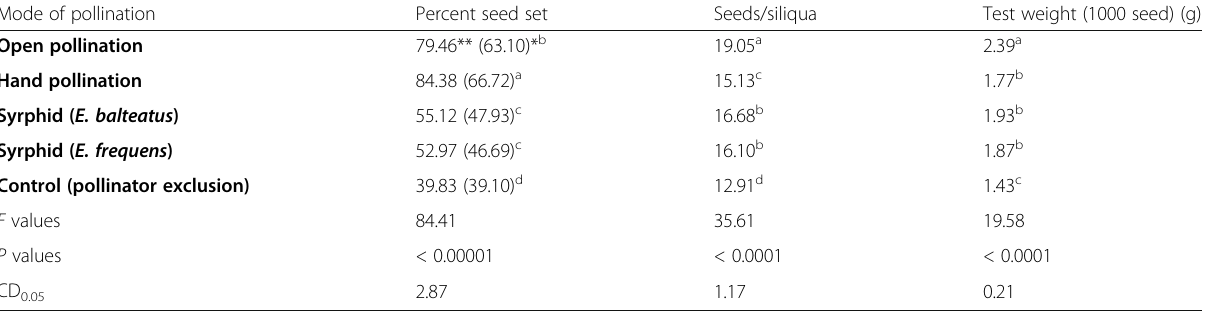
Table 5 Impact of different modes of pollination on percent seed set, number of seeds per siliqua, and test weight (1000 seeds) in